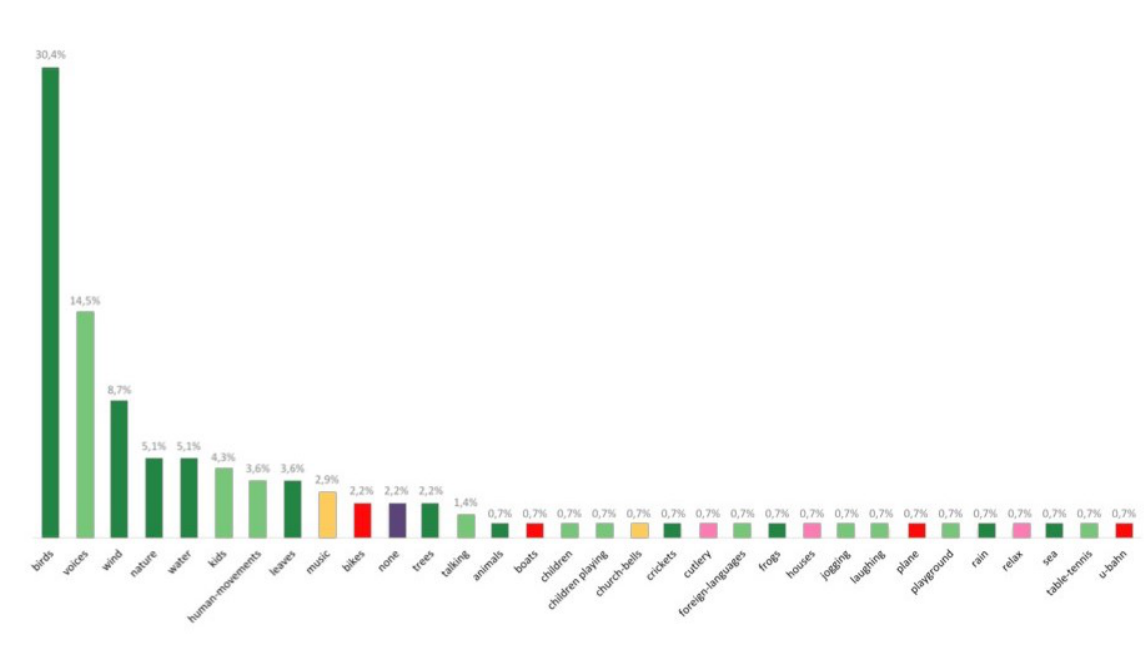
Figure 5: Diagram showing the sounds that contribute in a positive way to the app users’ sense of quietness in the “everyday quiet areas”. © A. Radicchi